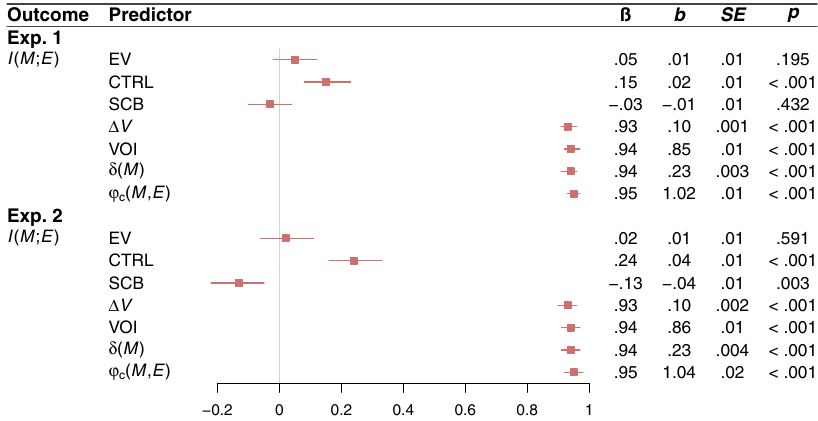
Fig. 3 Relationships between I(M;E) and variables of interest in experiments 1 and 2. Effects of all variables of interest on I M ; E ð Þ in experiment 1 (Exp. 1) and experiment 2 (Exp. 2). The variables of interest are expected value (EV), controllability (CTRL), skill-challenge balance (SCB), marginal value ( Δ V ), the value of information (VOI), temporal difference prediction error ( δ M ð Þ ), and the correlation between M and E ( φ (two-sided) performed over 720 observations across 365 participants in experiment 1, and 488 observations across 249 participants in experiment 2. Each LMM regresses I M ; E ð Þ on one variable from the predictor column, a nuisance regressor for game order ( fi rst game vs. second game), and random subject- level intercepts. Red squares denote standardized regression coef fi cients, and intersecting red lines represent 95% CIs. No corrections for multiple comparisons were